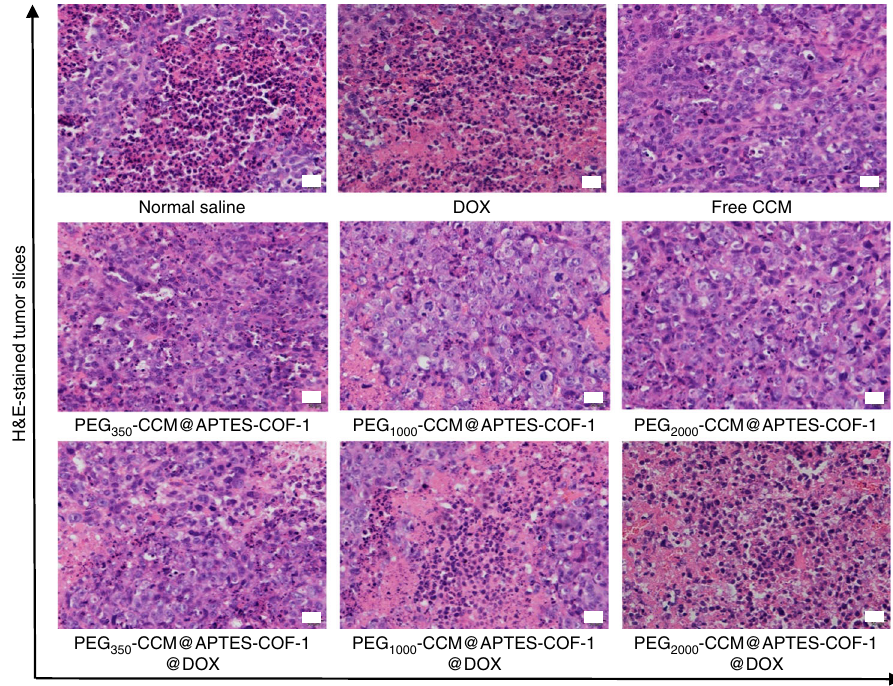
Fig. 6 Immunohistochemical analysis. H&E-stained tumor slices collected from different groups of mice on the following day after various treatments. For all images: scale bar represents 50 µ